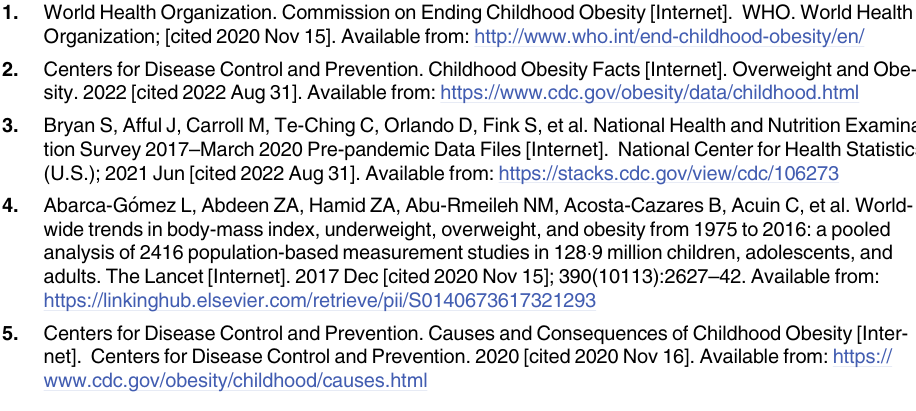
S1 Table. Results of logistic regression analysis of the effect modification by sleep duration on the association between time spent watching TV or playing video games and over-